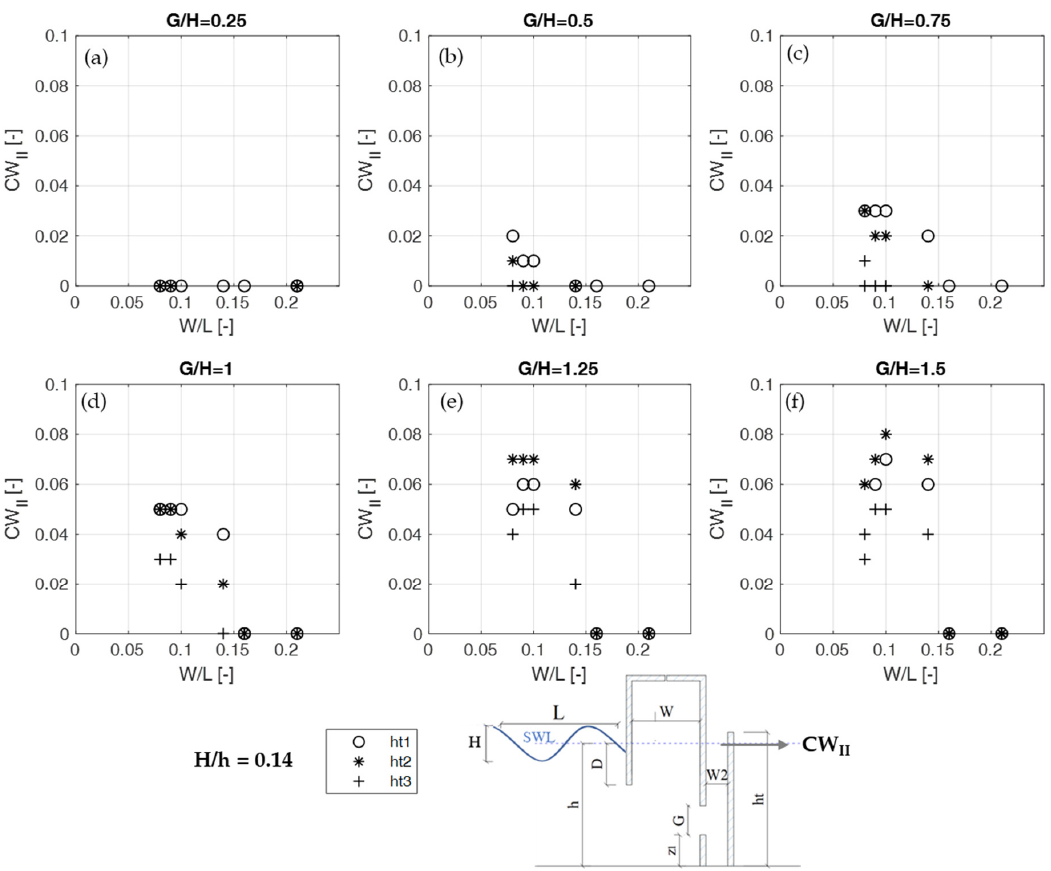
Figure 8. Capture width of the overtopping-based component of the device, CW II , as a function of the width of the OWC chamber, W / L , for different sizes of the aperture in the back wall relative to the incident wave height G / H = 0.25 ( a ), 0.5 ( b ), 0.75 ( c ), 1 ( d ), 1.25 ( e ), 1.5 ( f ). Results are obtained for H / h = 0.14.